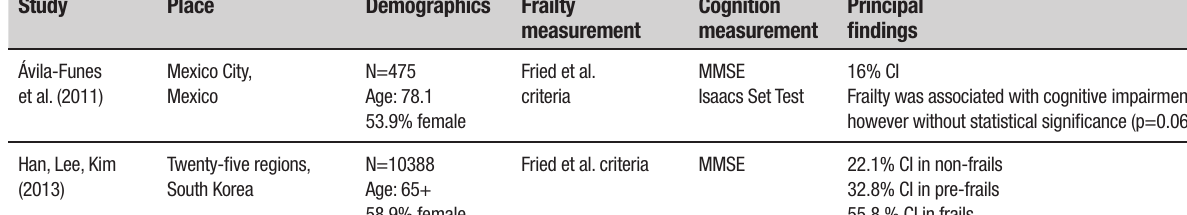
Table 1. Cross-sectional studies on the relationship between cognition and frailty in elderly.